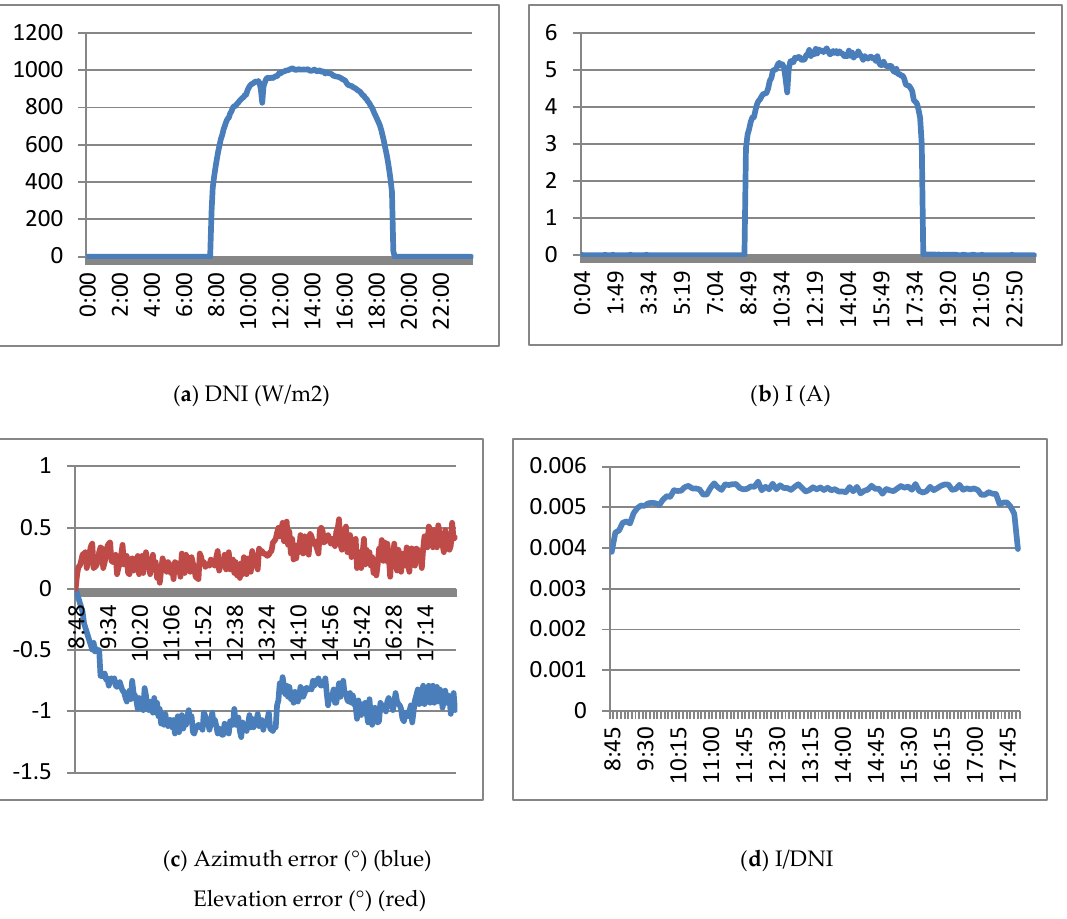
Figure 18. Results of the controller based on the FRBS sensor based on the electrical current generated. 14 March 2019.